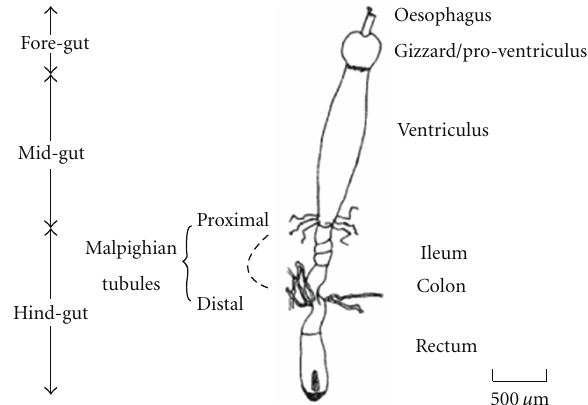
Figure 4: Schematic diagram of thoracic and abdominal sections of the alimentary tract of C. septempunctata .